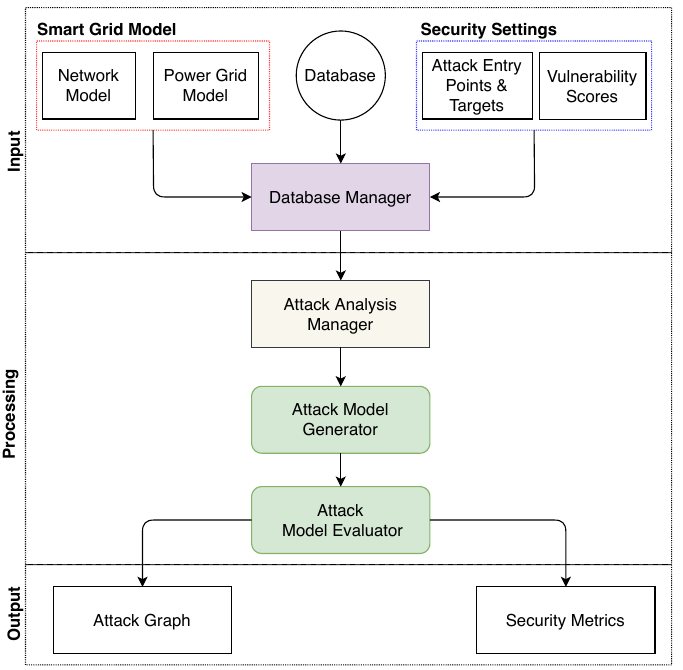
Figure 1. The architecture of